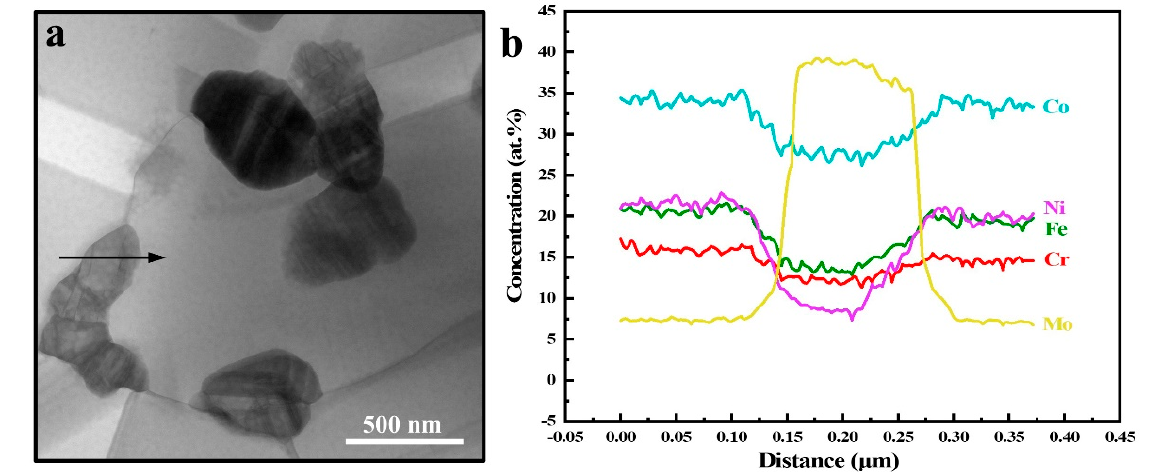
Figure 2. The STEM image and corresponding chemical composition analysis of the 1000 °C − annealed sample: ( a ) STEM image containing IMPs; ( b ) chemical composition of the elements constituting the IMPs plotted along the black arrows in ( a ). Table 1. The chemical composition ( at. % ) of the fcc matrix and μ -phase obtained by SEM-EDS and STEM-EDS in the Mo 10 HEA.